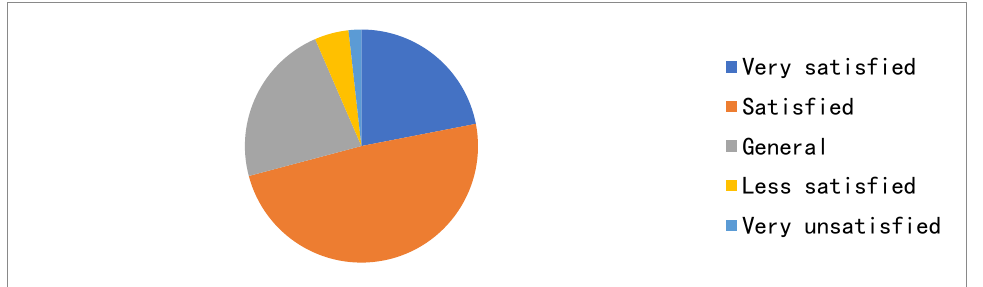
Figure 1. Current life satisfaction of empty-nest elderly in rural